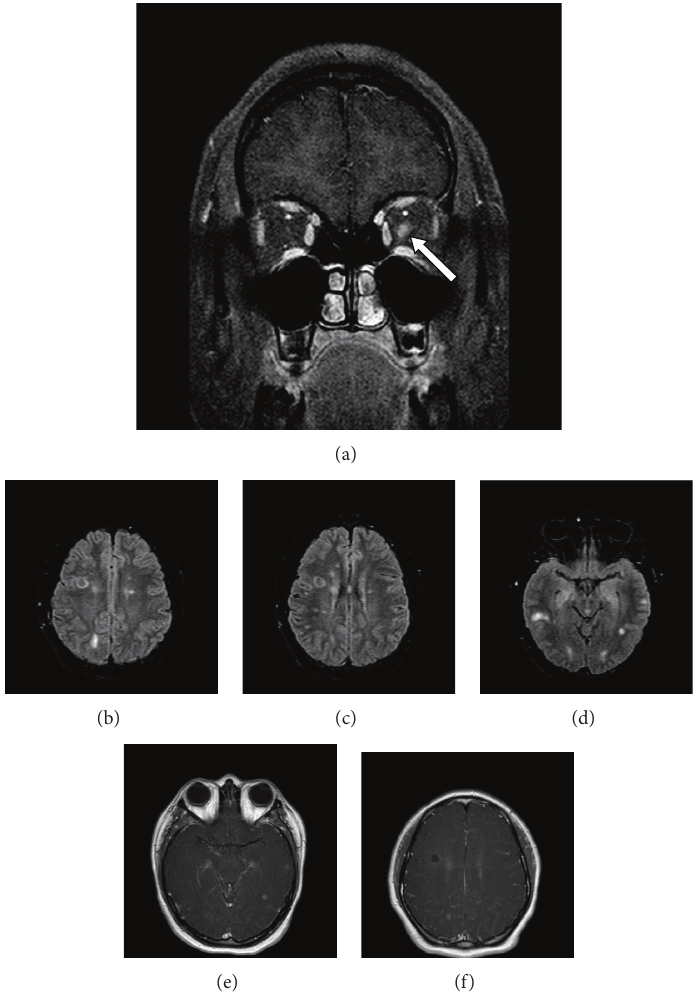
Figure 1: (a) Coronal T1 gadolinium enhanced sequence demonstrating left optic neuritis with enhancement and enlargement of the left optic nerve (arrow). (b) and (c) Axial FLAIR demonstrating typical well-circumscribed ovoid lesions in the juxtacortical and periventricular regions consistent with 2010 McDonald criteria for dissemination in space. (d) and (e) Axial FLAIR and gadolinium enhanced sequences with corresponding asymptomatic enhancing and nonenhancing lesions consistent with 2010 McDonald criteria for dissemination in time. (f) Axial T1 sequence with hypointense lesion associated with acute demyelination and axonal